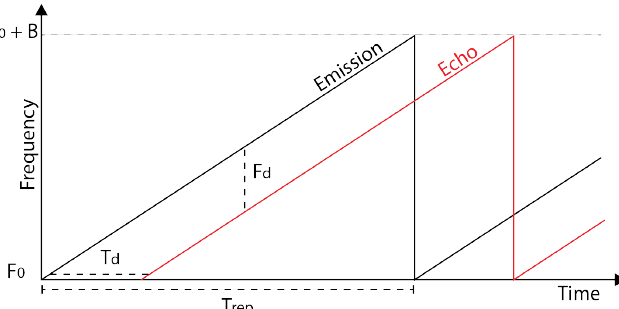
Figure 2. Transmitted up-chirp radar waveform and the corresponding echo signal arriving at the receiver from a single stationary point target. If multiple targets are present at different ranges, F d is the linear combination of the response for each point target.